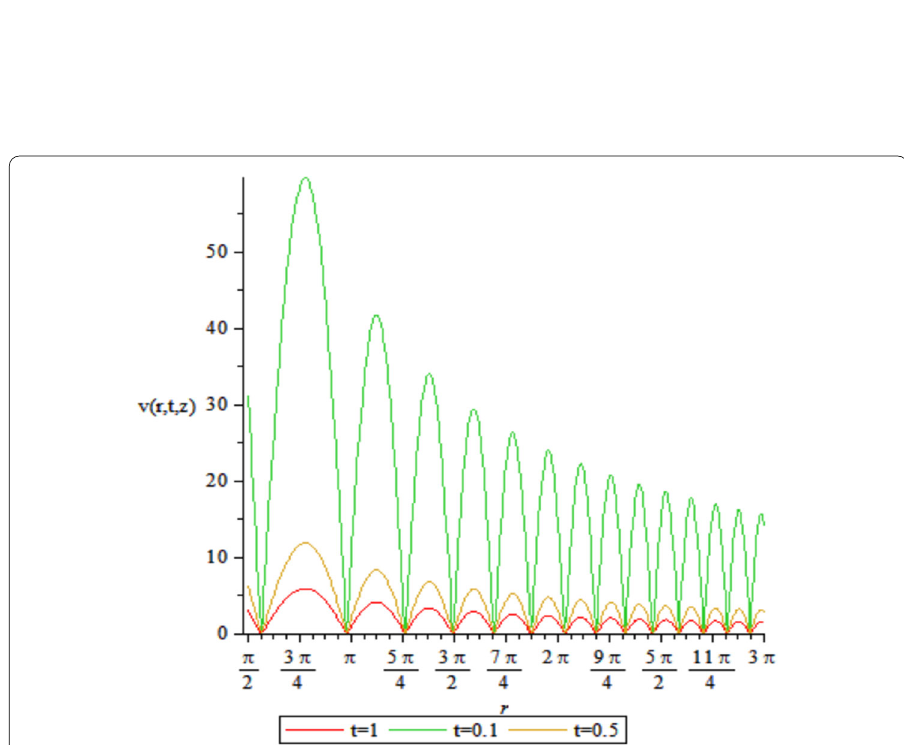
Figure 6 Positive case velocity component v ( r , t , z ) at z = 2, c 1 = 1, c 3 = I , and c 4 = 2